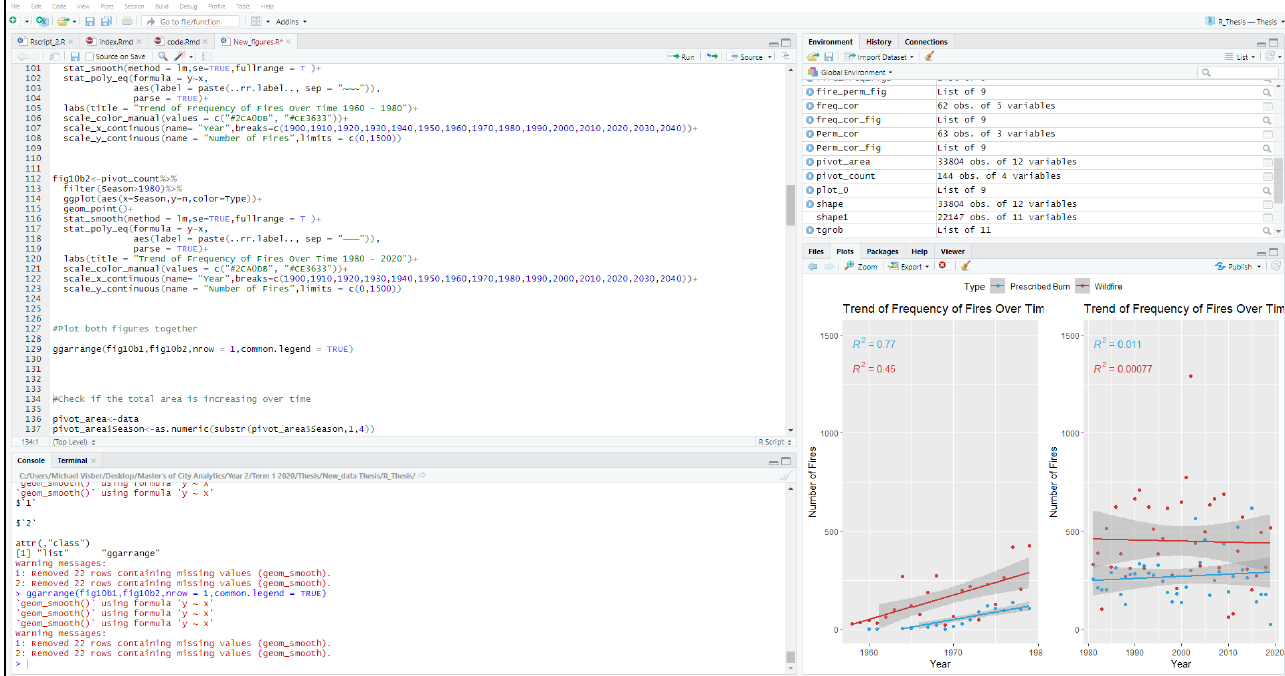
Figure 3. Snippet of R scripts for the linear modelling.